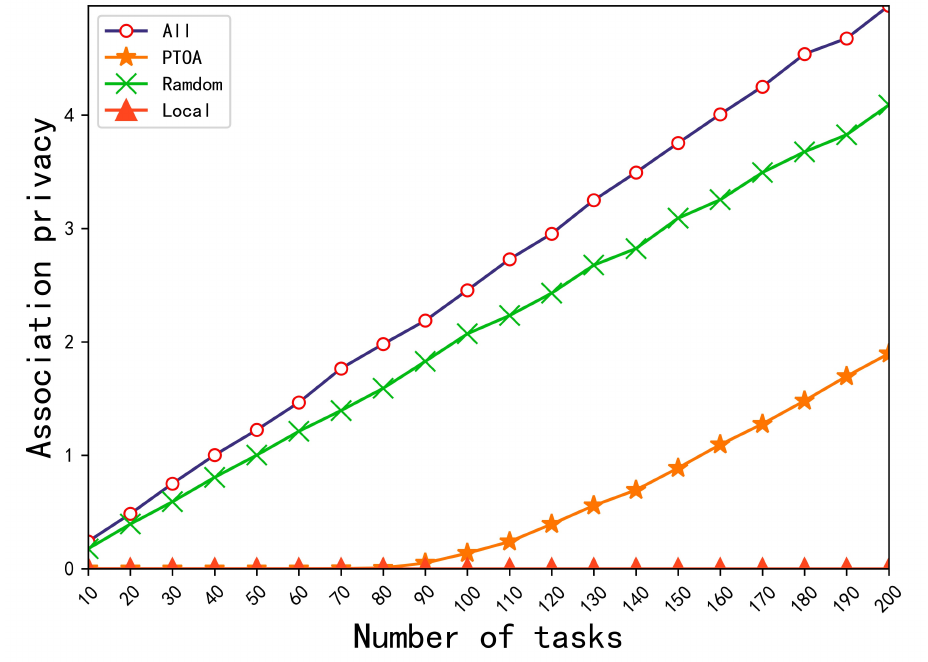
Figure 3. Comparison of the association privacy-preserving ability for four methods, All, PTOA, Random, and Local, with different numbers of